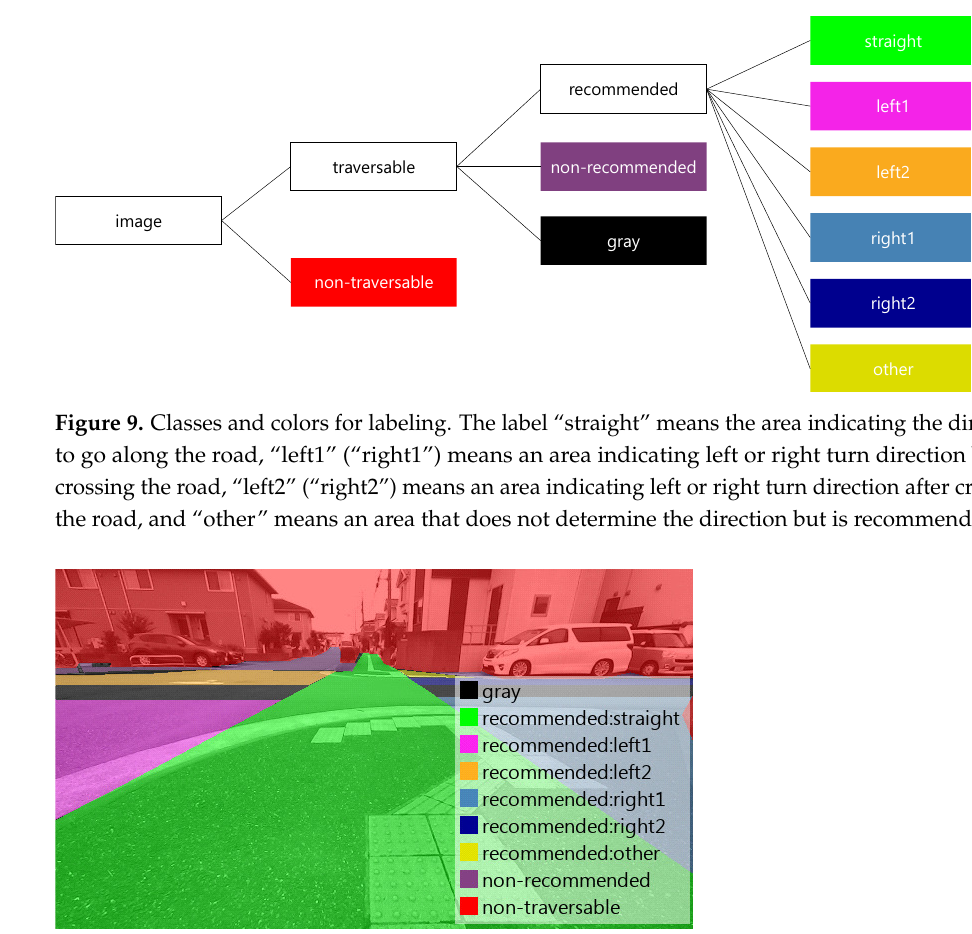
Figure 10. Example of labeled image for